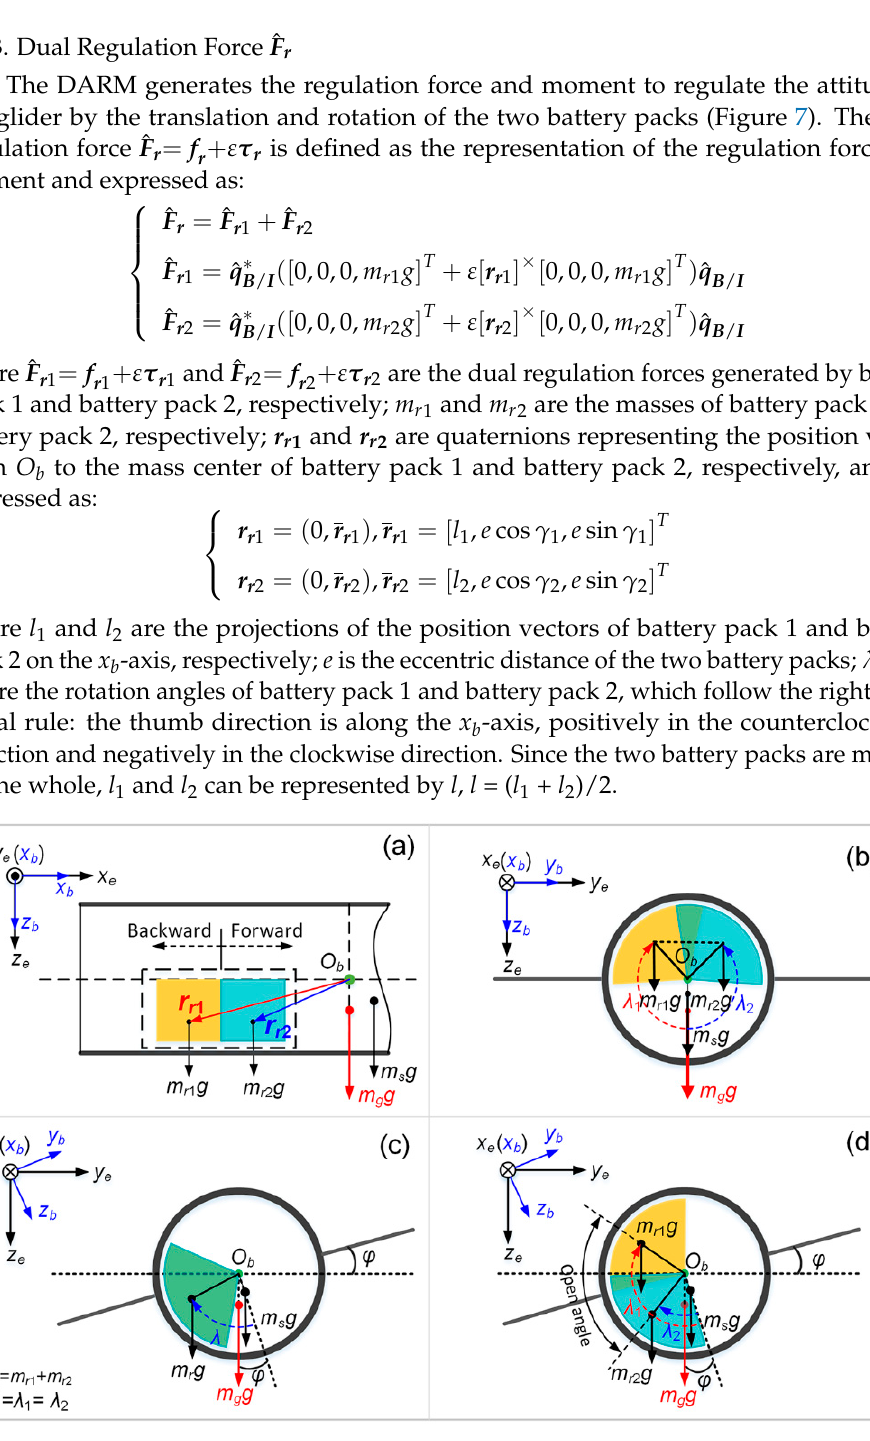
Figure 7. Regulation of the two battery packs by DARM: ( a ) Translation movement along the x b -axis in the vertical plane; ( b ) Opposite direction rotation around the x b -axis at equal angles ( λ 1 = − λ 2 ); ( c ) Same direction rotation around the x b -axis at equal angles ( λ 1 = λ 2 ); ( d ) Same direction rotation around the x b -axis at equal angles (with an open angle equals to λ 1 − λ 2 ).